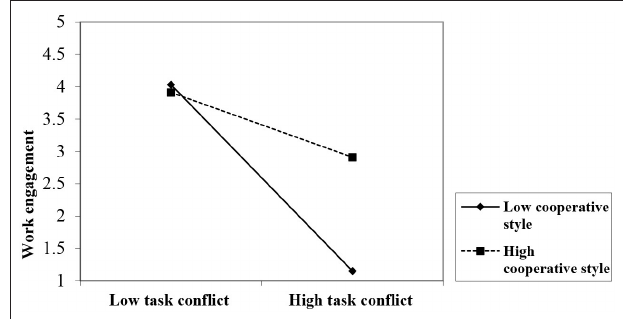
FIGURE 3 | The moderating effect of conflict management style on the relationship between task conflict (TC) and work